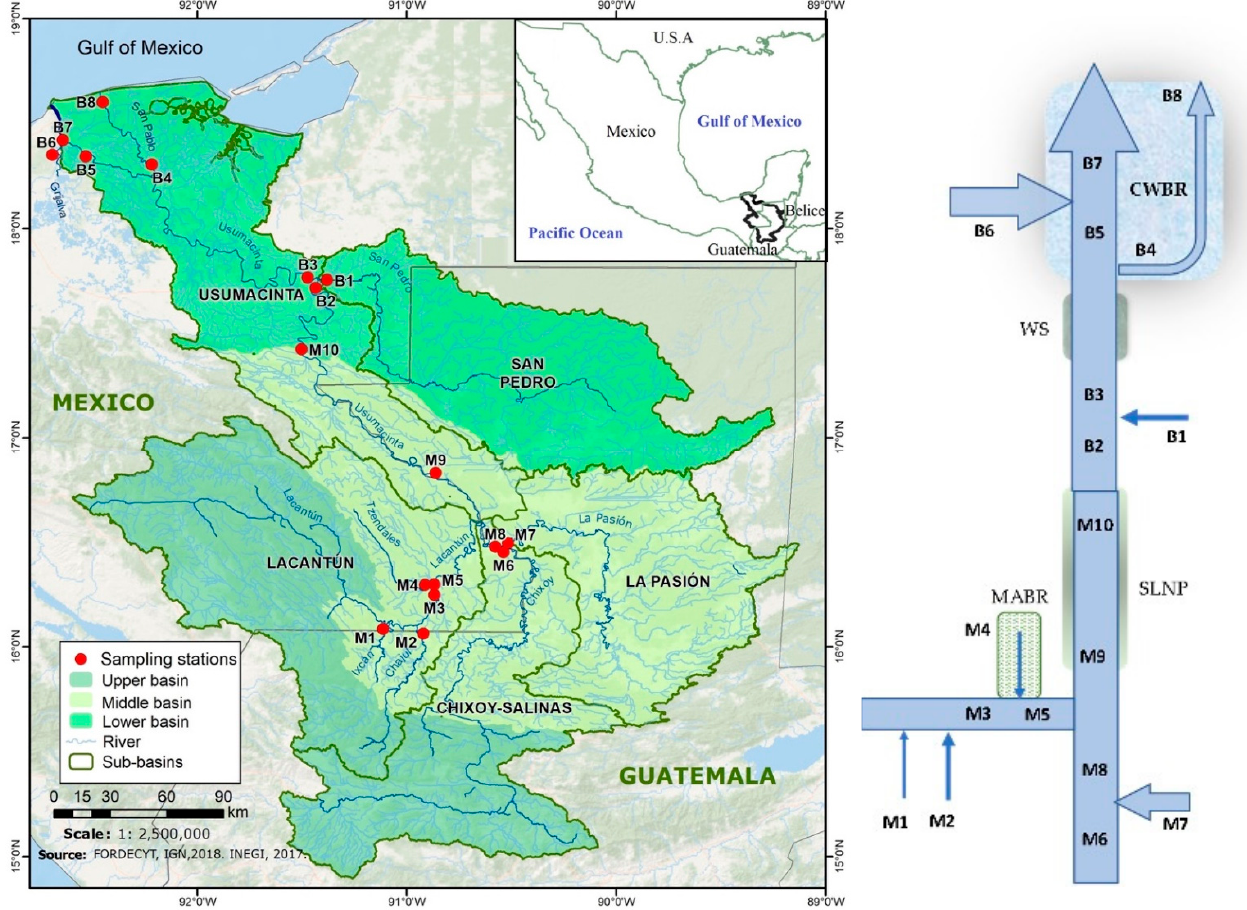
Figure 1. Map ( left ) and diagram ( right ) of the Usumacinta River basin indicating the sampling stations. (M = middle basin and B = lower basin stations). MABR = Montes Azules Biosphere Reserve; SLNP = Sierra de Lacandon National Park; WS = wetland system; CWBR = Pantanos de Centla Biosphere Reserve.